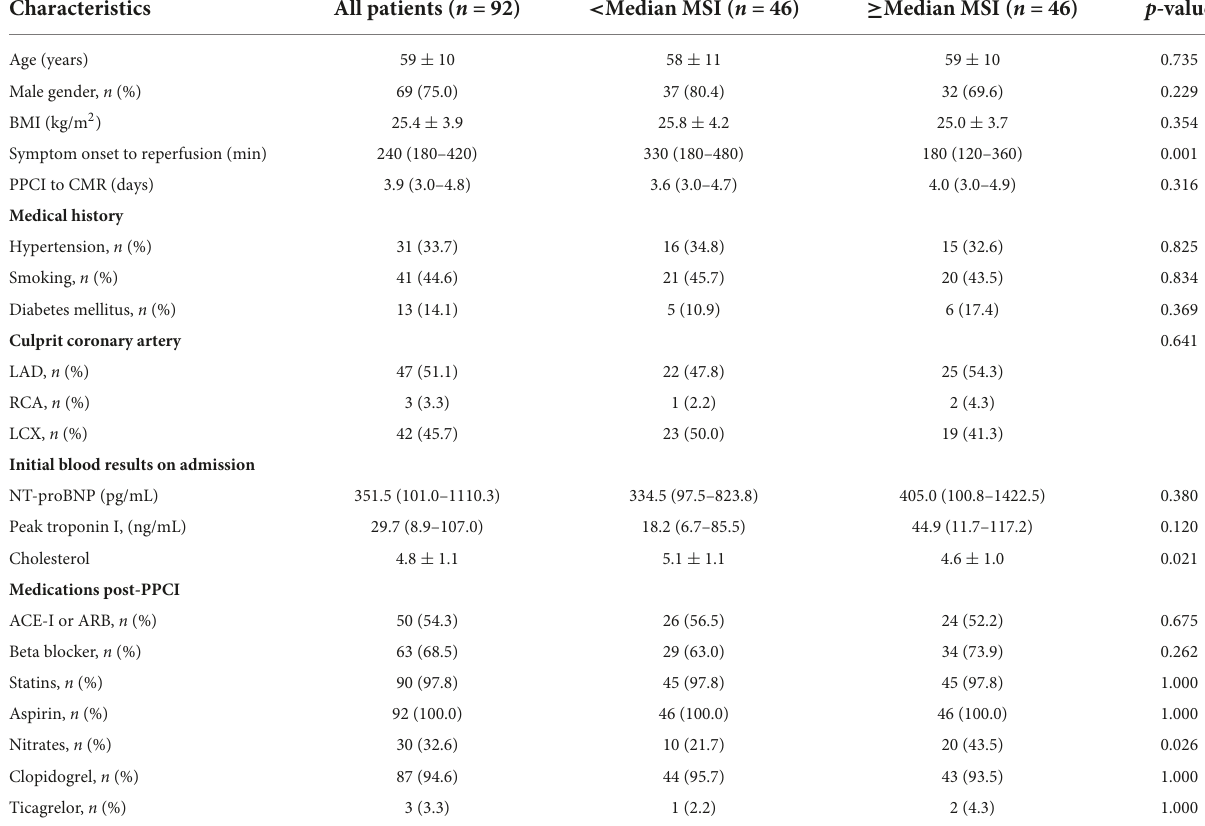
TABLE 1 Demographic data and clinical characteristics of patients with STEMI.